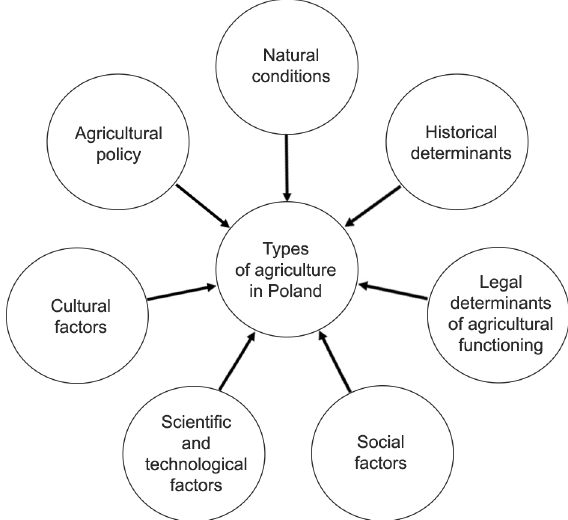
Fig. 1. Conditions and factors determining the types of agriculture in Poland after 1945. Source: own